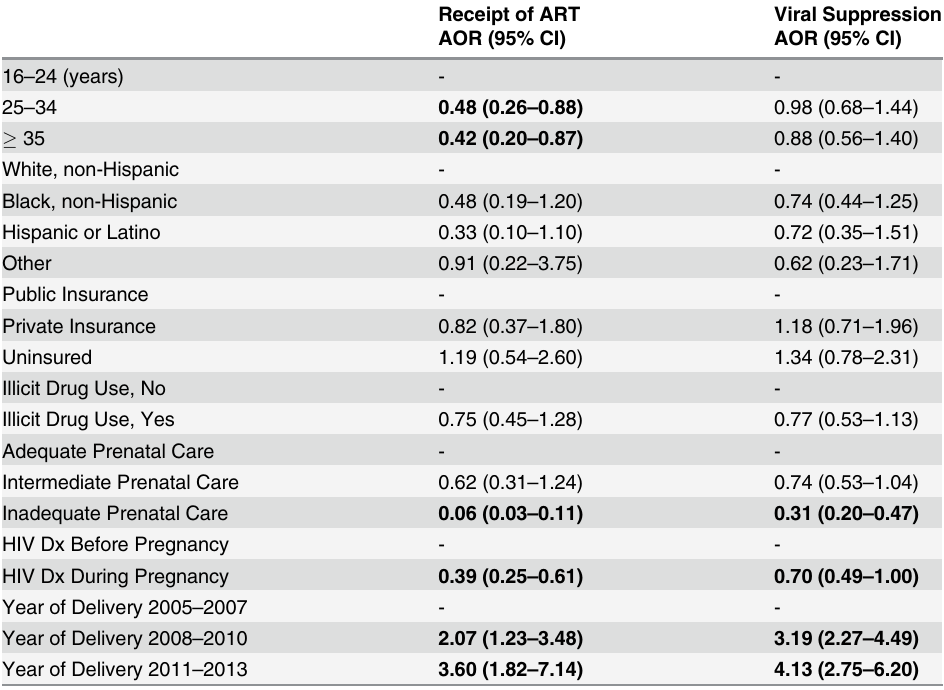
Table 2. Demographic, Behavioral and Clinical Factors associated with 1) ART Prescription and 2) HIV Viral Suppression using Multivariate Logistic